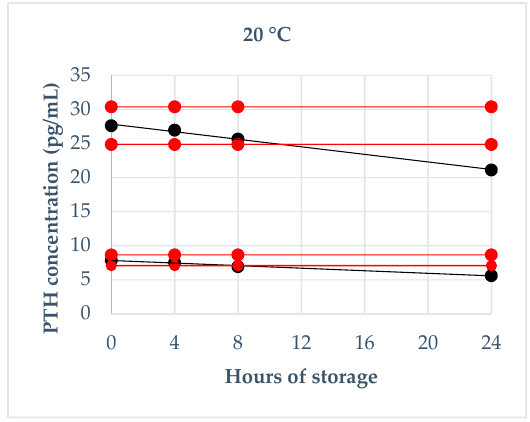
Figure 2. PTH stability at 20 °C during 24 h of storage (4 h, 8 h and 24 h): the black lines indicate the tendency of the obtained values; the red lines indicate ± 10% from the baseline value. Animals 2020 , 10 , x